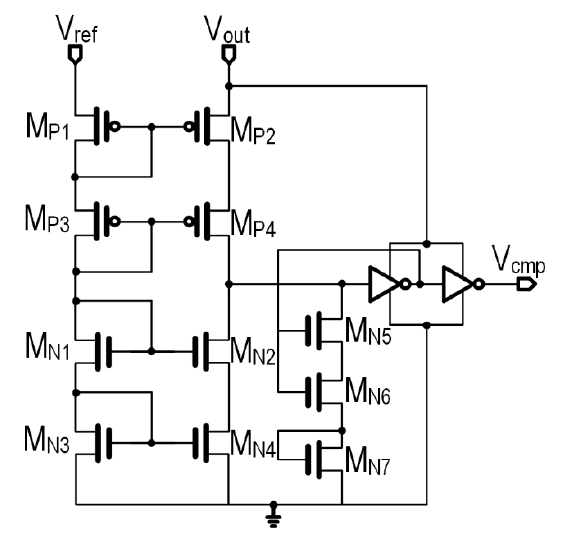
Figure 11. Common-gate comparator.